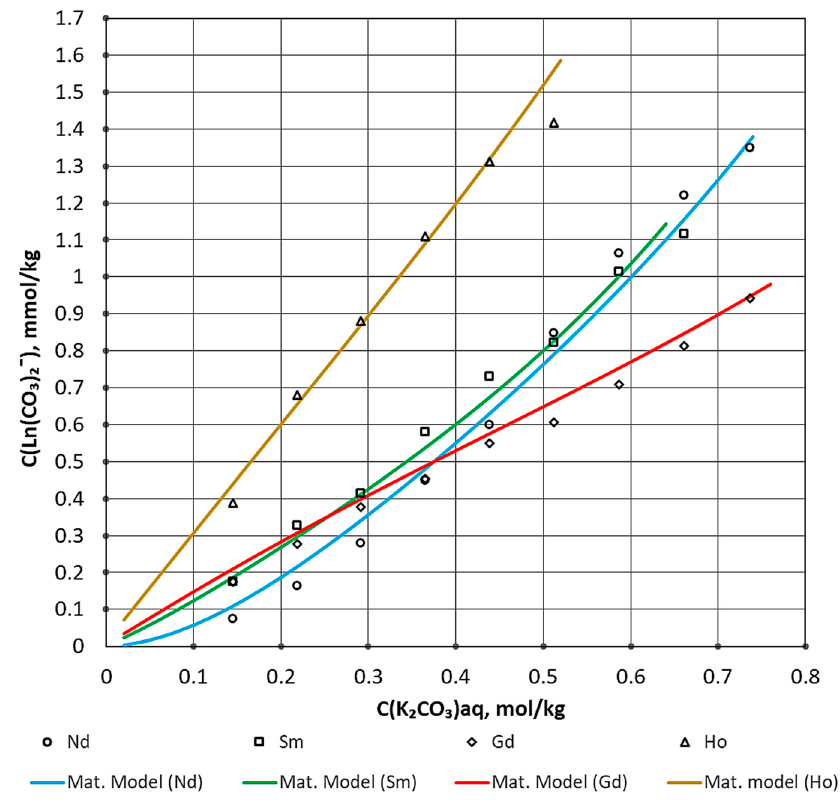
Figure 2. Isotherm of solubility for REE in carbonate–alkaline medium.